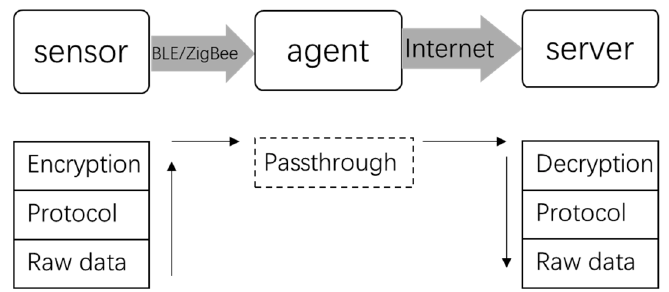
Figure 1. Data-flow block diagram of system.